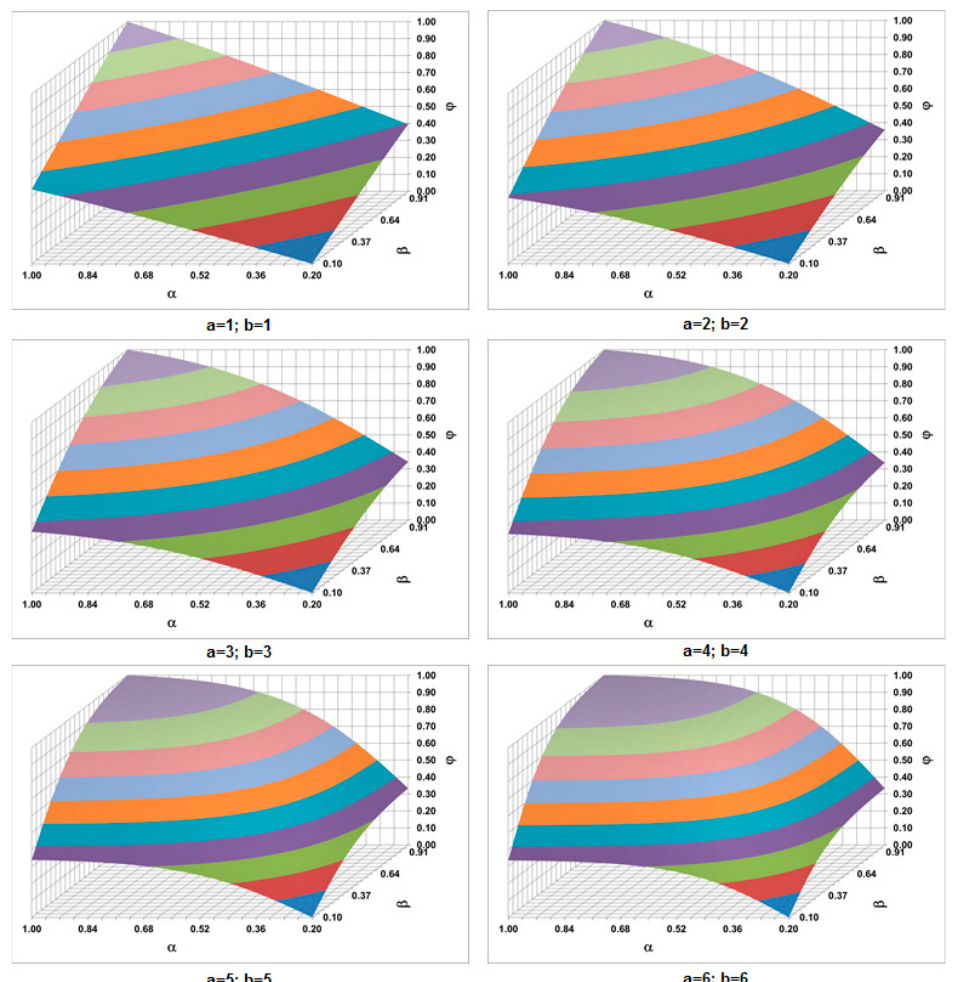
Figure 4. Different shapes of sigmoid-like function depending on a, b values ( α 0 = 0.2; β 0 = 0.1).